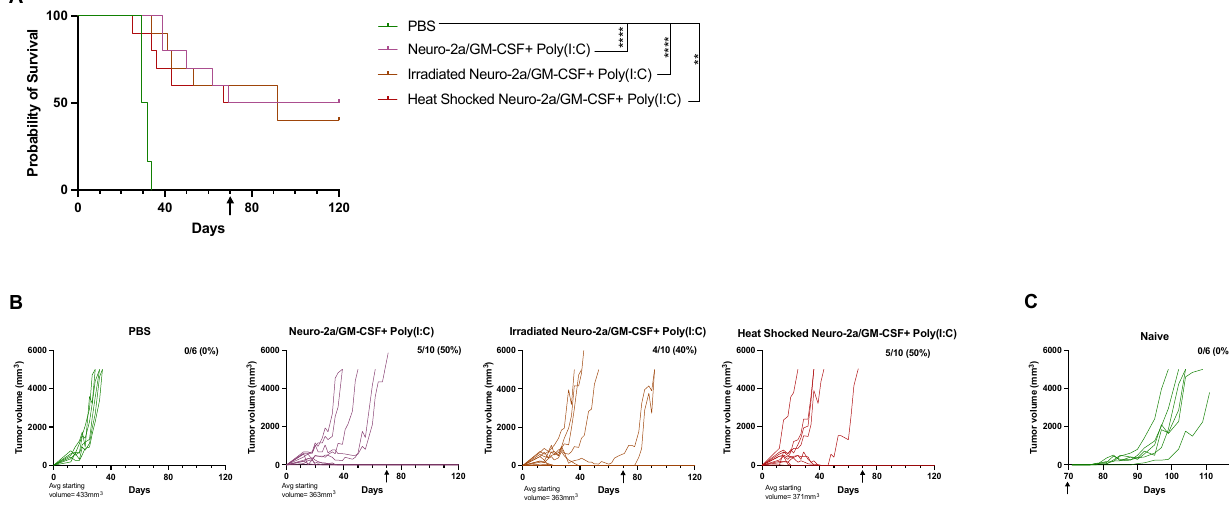
Figure 2. Irradiating or heat-stressing allogeneic GM-CSF-secreting cells prior to co-injecting with Poly(I:C) does not augment A20 tumor control above that seen with live cell injection. Mice bearing A20 tumors were randomized into treatment groups and received intratumoral injections of indicated treatments twice a week for 4 weeks for a total of 8 injections. ( A ) Survival of mice in indicated groups are illustrated with a Kaplan-Meier survival curve. Statistical differences were assessed using the Log rank test with the level of significance denoted by the number of asterisks: ** p < 0.01, **** p < 0.0001. ( B ) Tumor growth of individual mice. Tumors were sized 2–3 times per week and calculated as described in Section 2. Mice were removed from study once a tumor size of > 5000 mm 3 was reached. ( A , B ) Tumor-free mice were rechallenged with A20 tumor on the opposing flank at day 70, indicated by the black arrow on graphs. ( C ) Growth of A20 tumors in naïve mice used as controls.